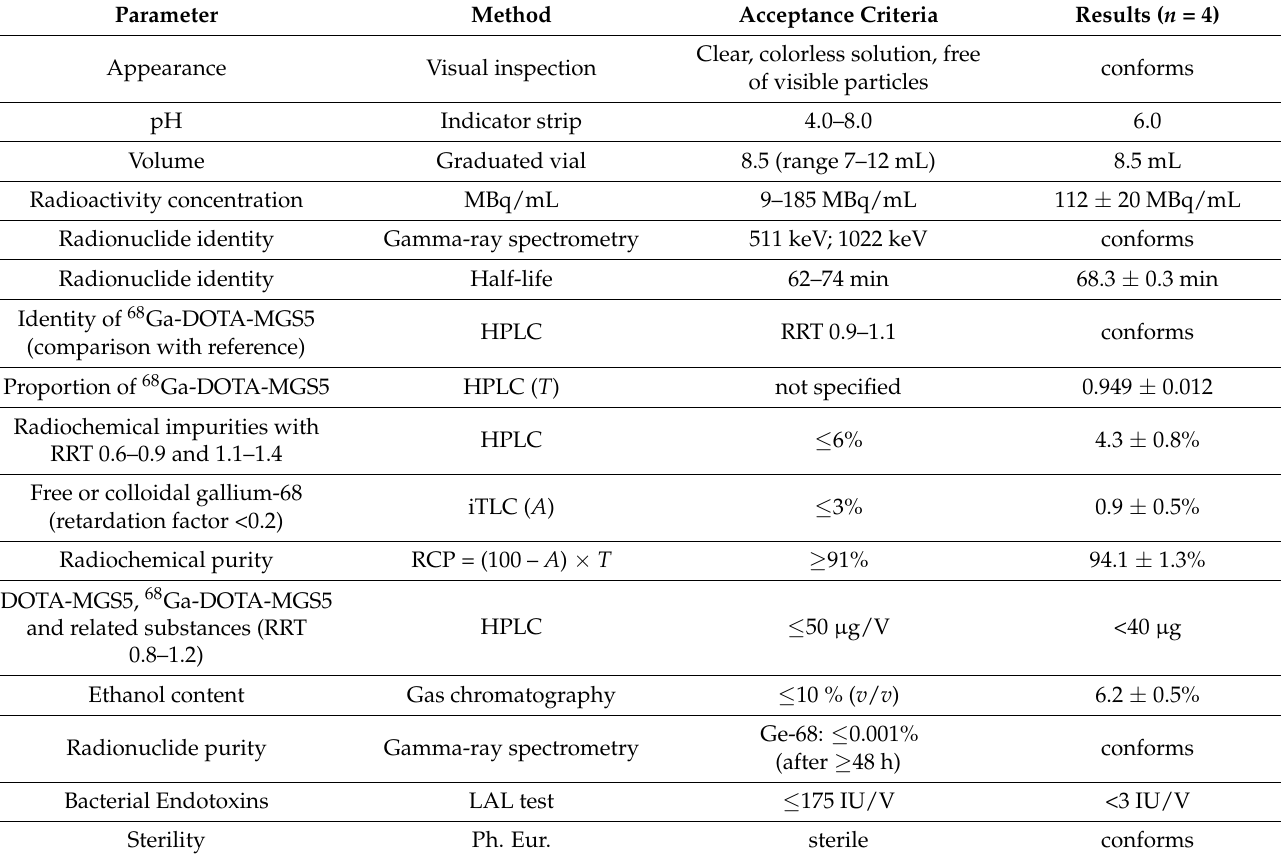
Figure 2. Scheme of the automated cassette-based production of 68 Ga-DOTA-MGS5. Table 1. Batch analysis table of four consecutive batches of 68 Ga-DOTA-MGS5.